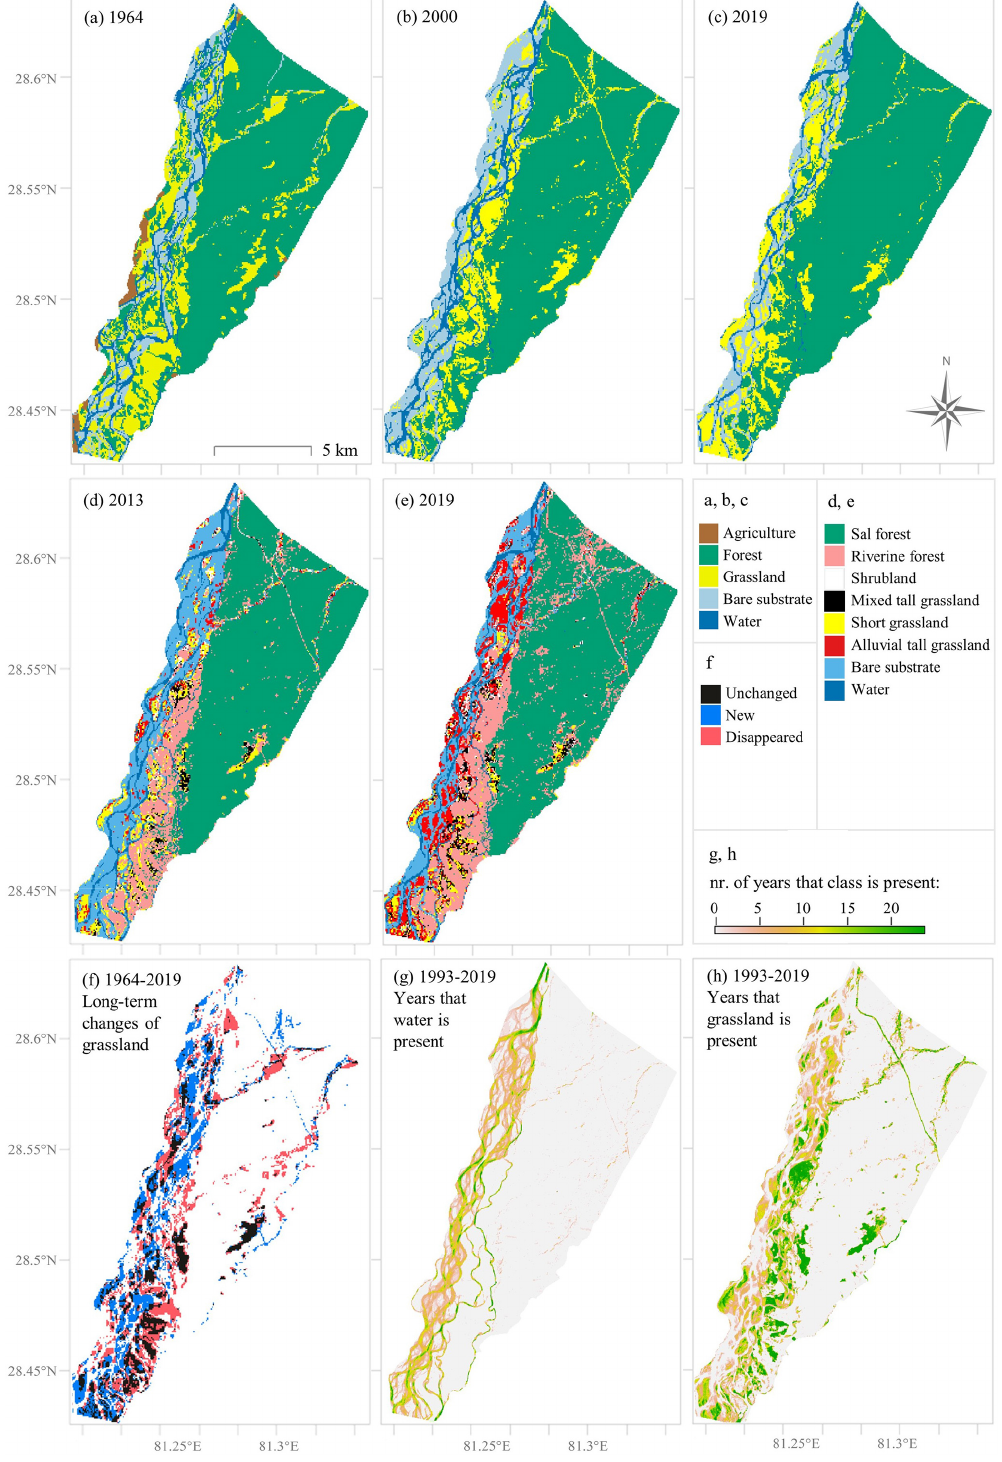
Figure 3. Overview of land cover maps. (a) The manual delineation of land cover classes from the aerial photograph composite of 1964, (b, c) the level 1 dataset, (d, e) the level 2 dataset, (f) the grasslands that are present in 1964 and during 2017–2019 and where they appeared and disappeared, (g, h) and the number of years in total that water and grassland were present during the time period 1993–2019 (calculated from level 1 dataset). The full series of land cover maps is presented in Fig.